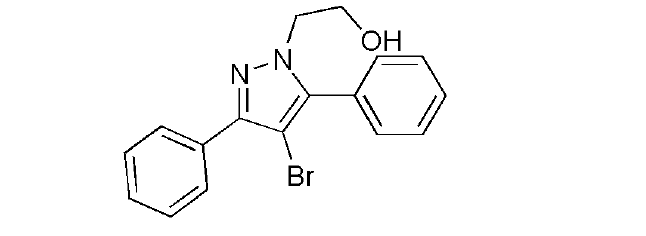
Figure 2. Chemical structure of BBB4.